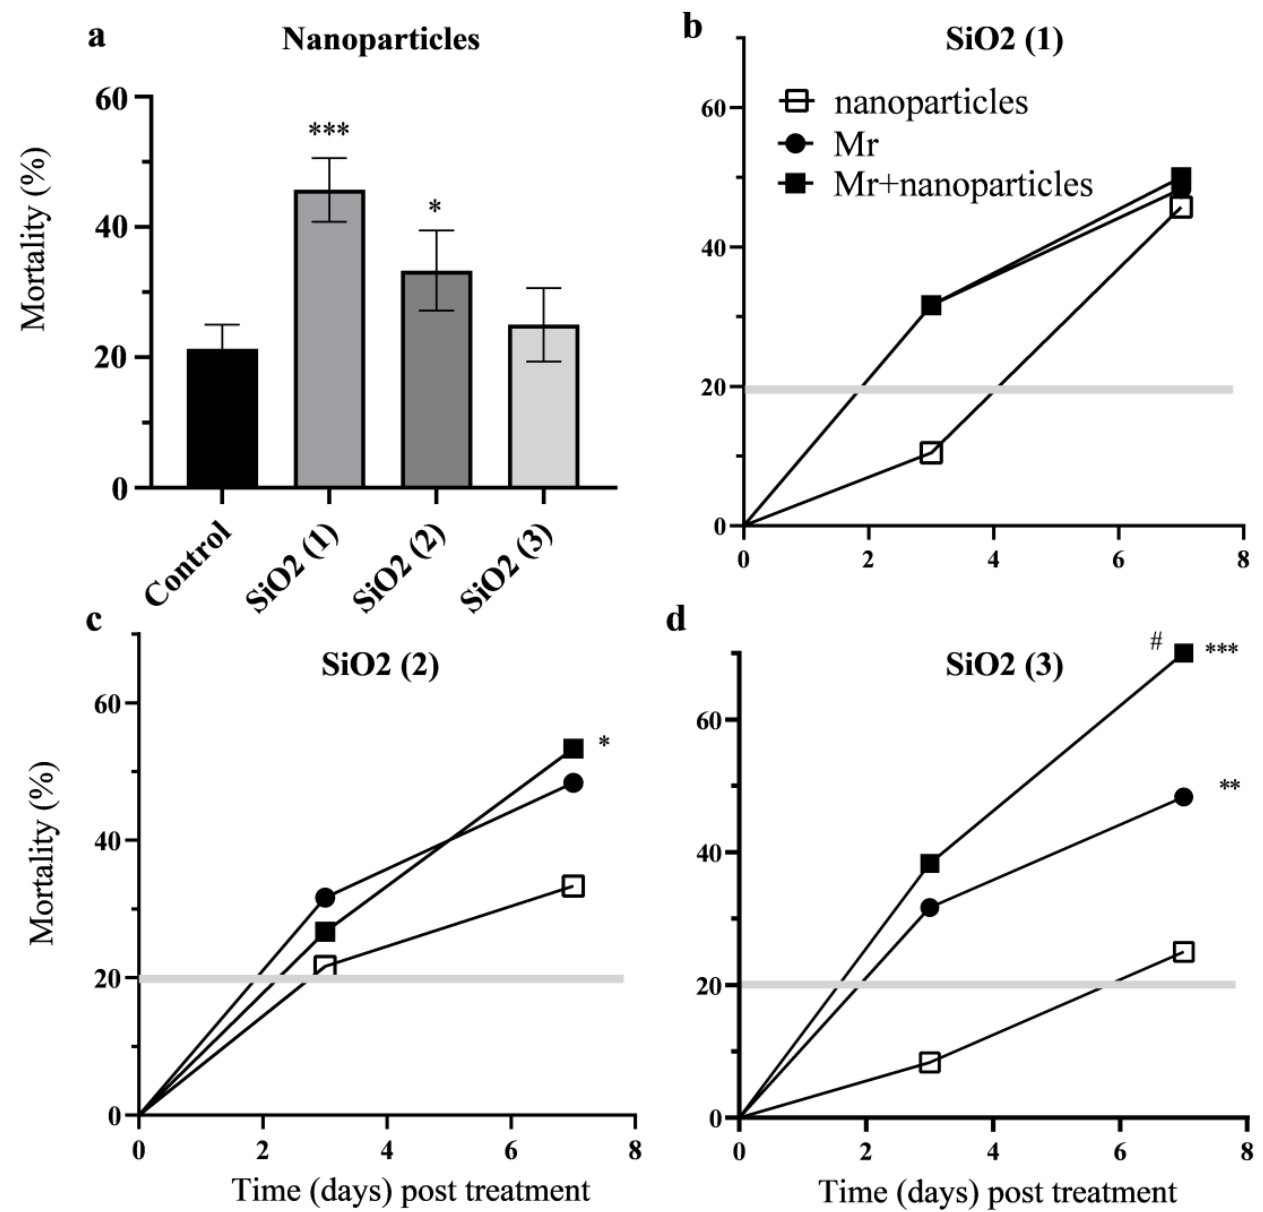
Figure 2. Survival of Leptinotarsa decemlineata larvae over seven days following treatment with silicon dioxide nanoparticles with epoxy (1 SiO 2 ), silane (2 SiO 2 ), amino (3 SiO 2 ) groups ( a ), fungus Metarhizium robertsii (Mr) and combination (Mr + nanoparticles) ( b – d ); The gray bar represents the mortality (mean) in control (* p < 0.05; ** p < 0.01; *** p < 0.001 compared with treatment by nanoparticles, # p < 0.05 compare with treatment by Mr) ( b – d ).